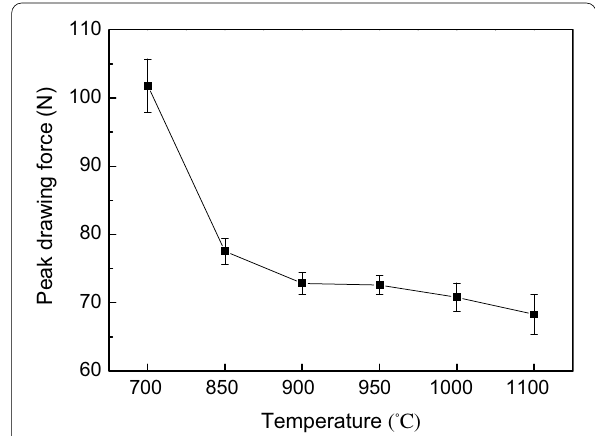
Figure 5 Dependence of peak drawing force on annealing